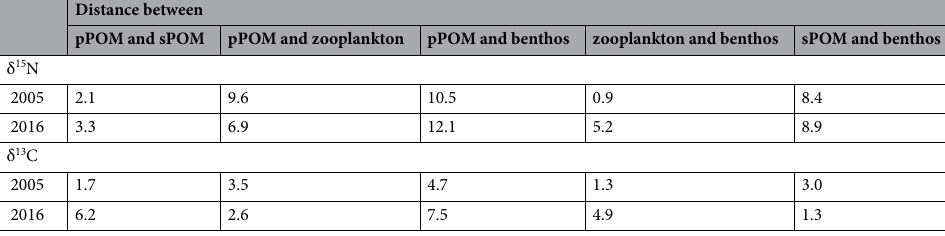
pPOM and sPOM pPOM and zooplankton pPOM and benthos zooplankton and benthos sPOM and